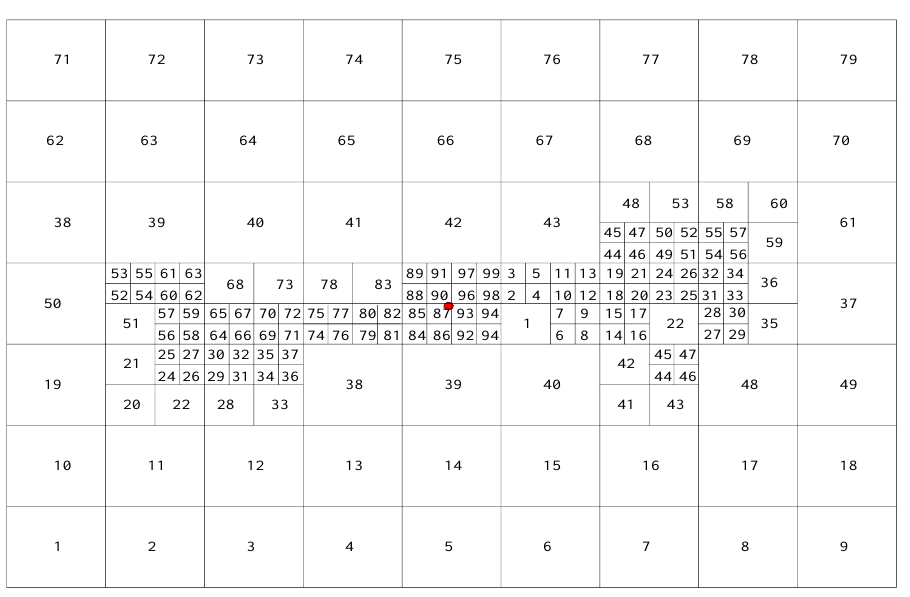
Figure 8. Grid sorting in local grid refinement. (The red dot refers to the wellbore).